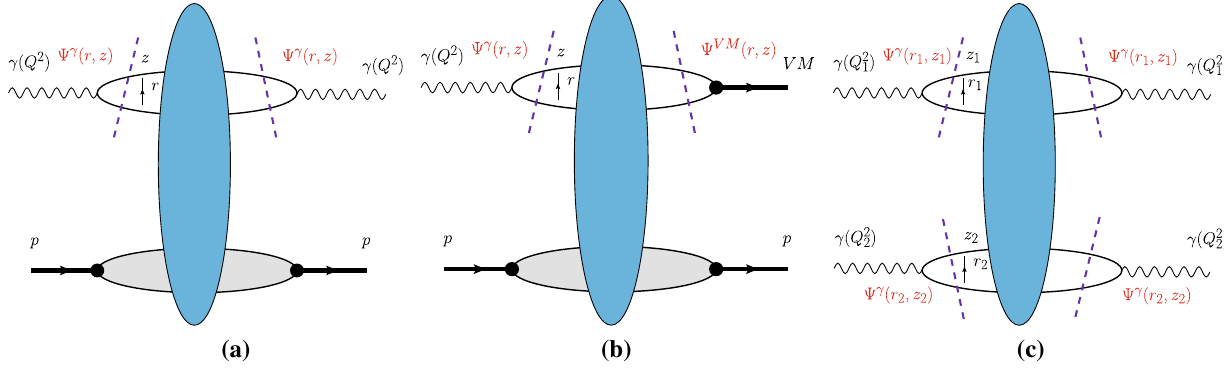
Fig. 1 Diagrammatic representation of the scattering amplitude for the a elastic γ ∗ p , b exclusive ρ meson and c γ ∗ γ ∗